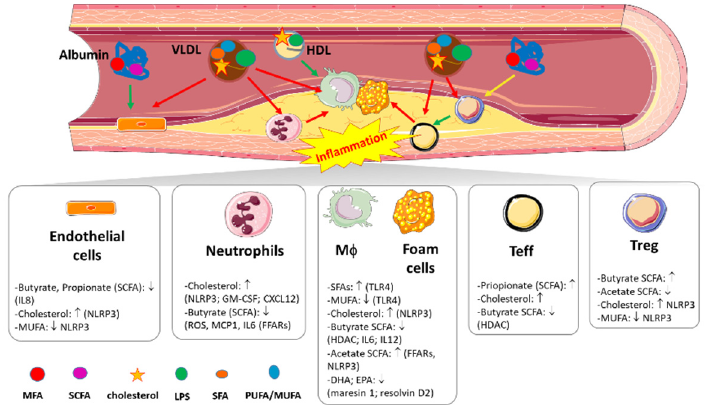
Figure 2. Principal immune-inflammatory pathways elicited by dietary fats in atherosclerosis. VLDL = very low density lipoproteins; HDL = high density lipoproteins; LPS = lipopolysaccharide; M ϕ = macrophages; Teff = effector T cells; Treg = regulatory T cells; SFAs = saturated fatty acids; SCFAs = short chain fatty acids; MUFA = mono-unsaturated fatty acids; PUFA = poly-unsaturated fatty acids; DHA = docosahexaenoic acid; EPA = eicosapentaenoic acid; NLRP3 = NOD-like receptor protein 3; GM-SCF = granulocyte-coly stimulating factor; CXCL12 = C-X-C motif chemokine ligand 12; ROS = reactive oxygen species; MCP-1 = monocyte chemoattractant protein-1; FFARs = free fatty acids receptors; IL- = interleukin; HDAC = histone deacetylases. ↑ ”: indicates an activated cell or pathway; ↓ ” indicates an inhibited cell or pathway.